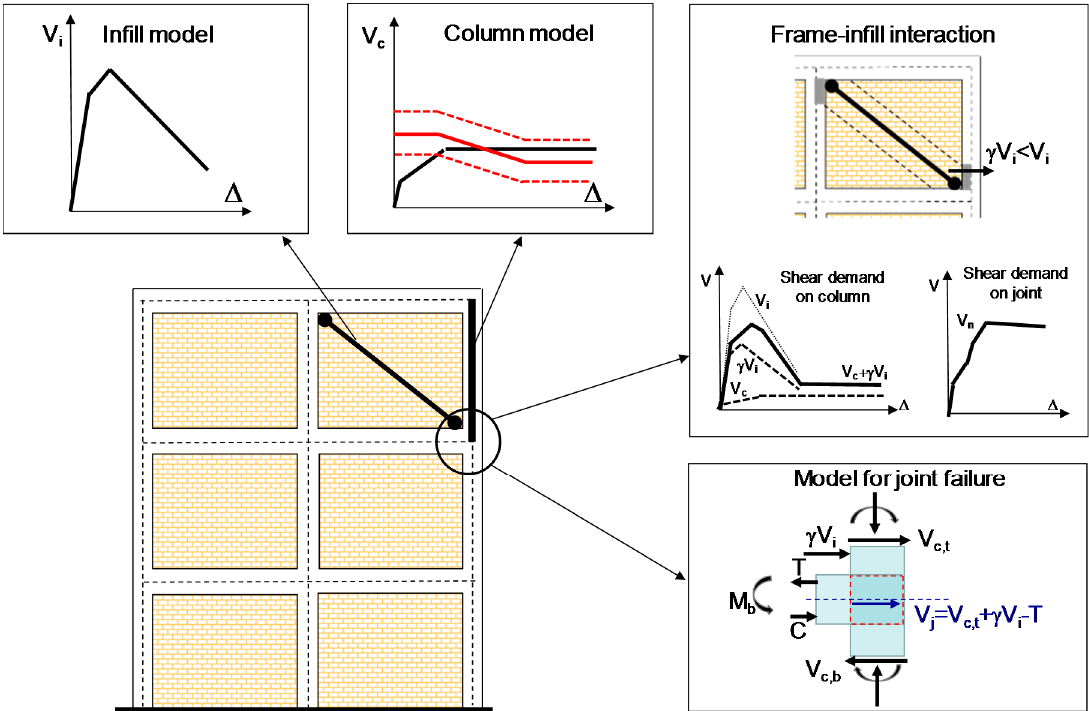
Figure 1. Schematic representation of the generic frame of the building with identification of the columns and infill panels and the nonlinear model adopted for each of these elements. The two panels on the right schematize frame-infill interaction and modeling approach to capture shear demand on columns and joints.